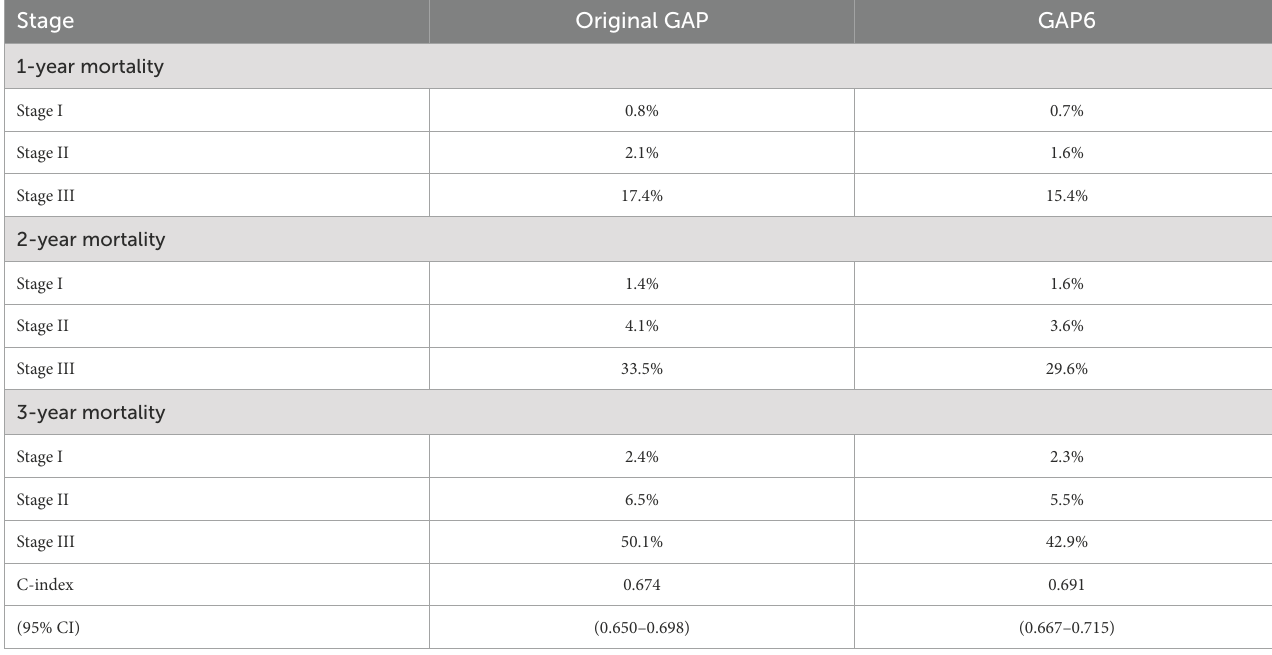
TABLE 6 Mortality rates for patients in different stages according to the original and modified GAP